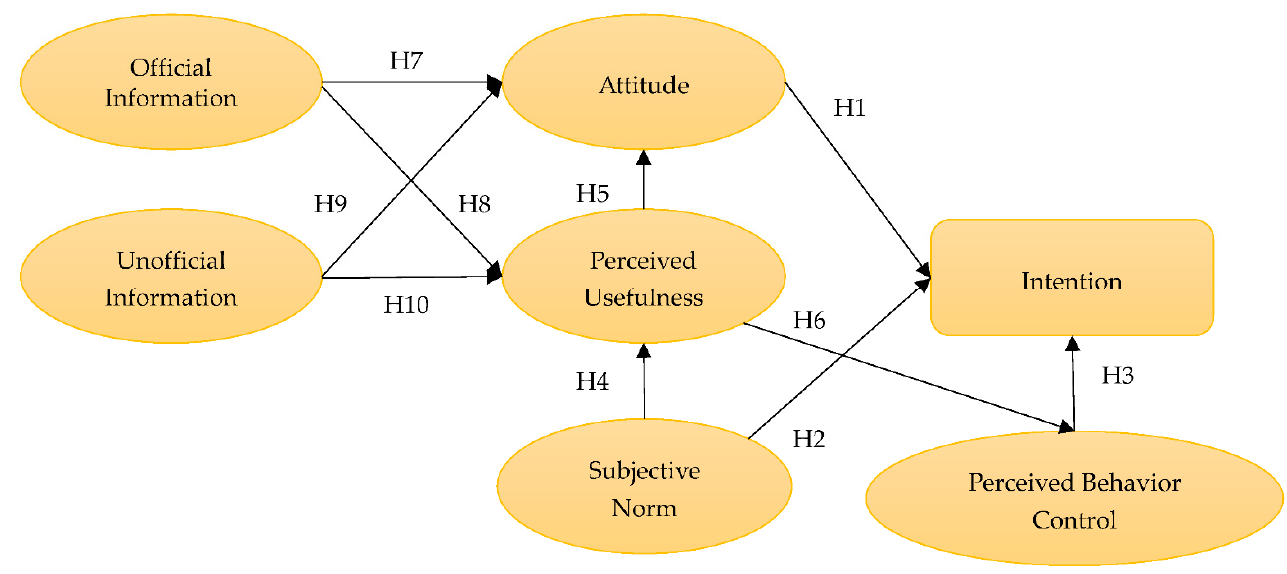
Figure 1. Proposed theoretical framework.